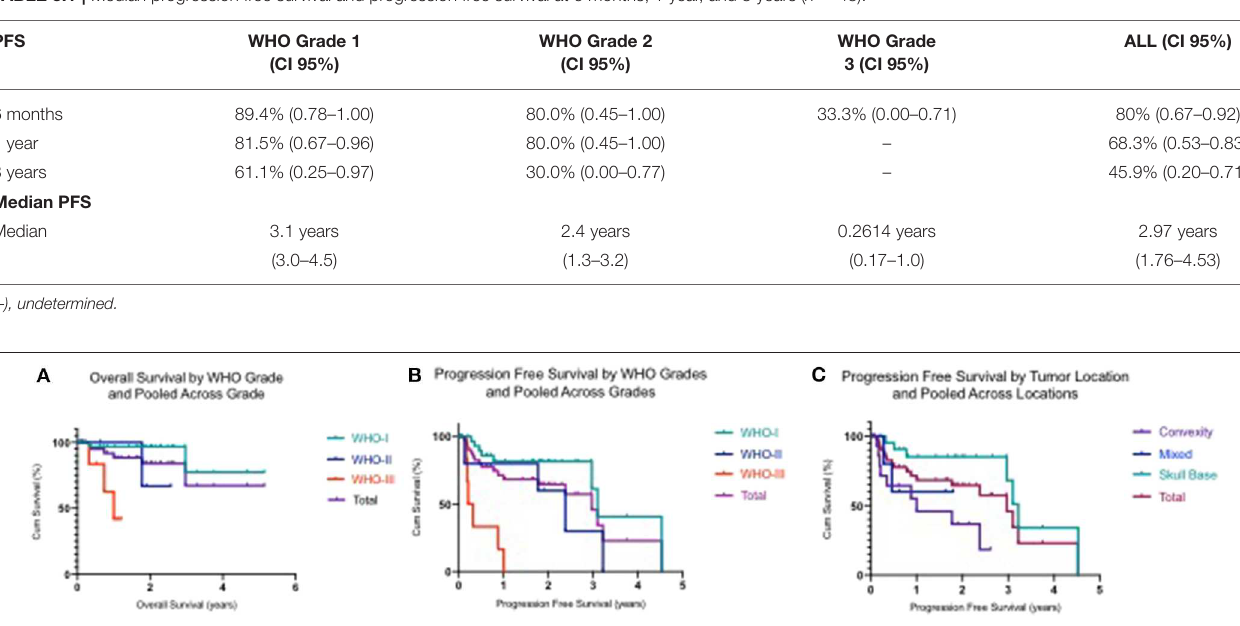
TABLE 3.1 | Median progression free survival and progression free survival at 6 months, 1 year, and 3 years ( n = 43).